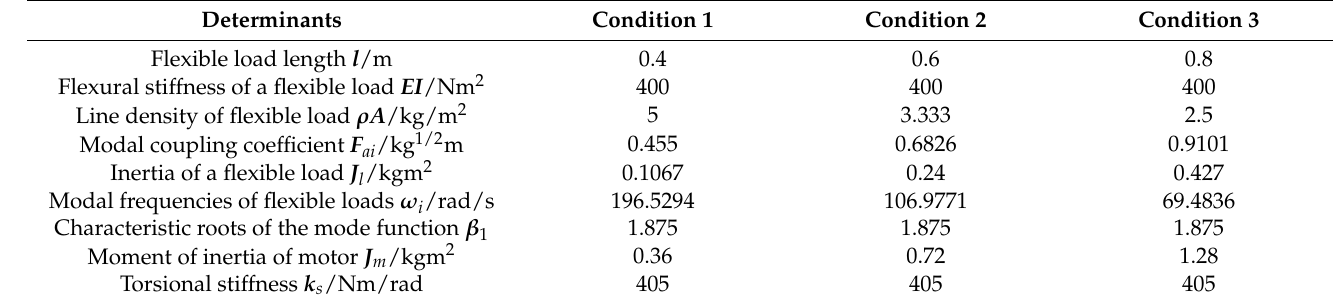
Table 5. Flexible load parameters in 3